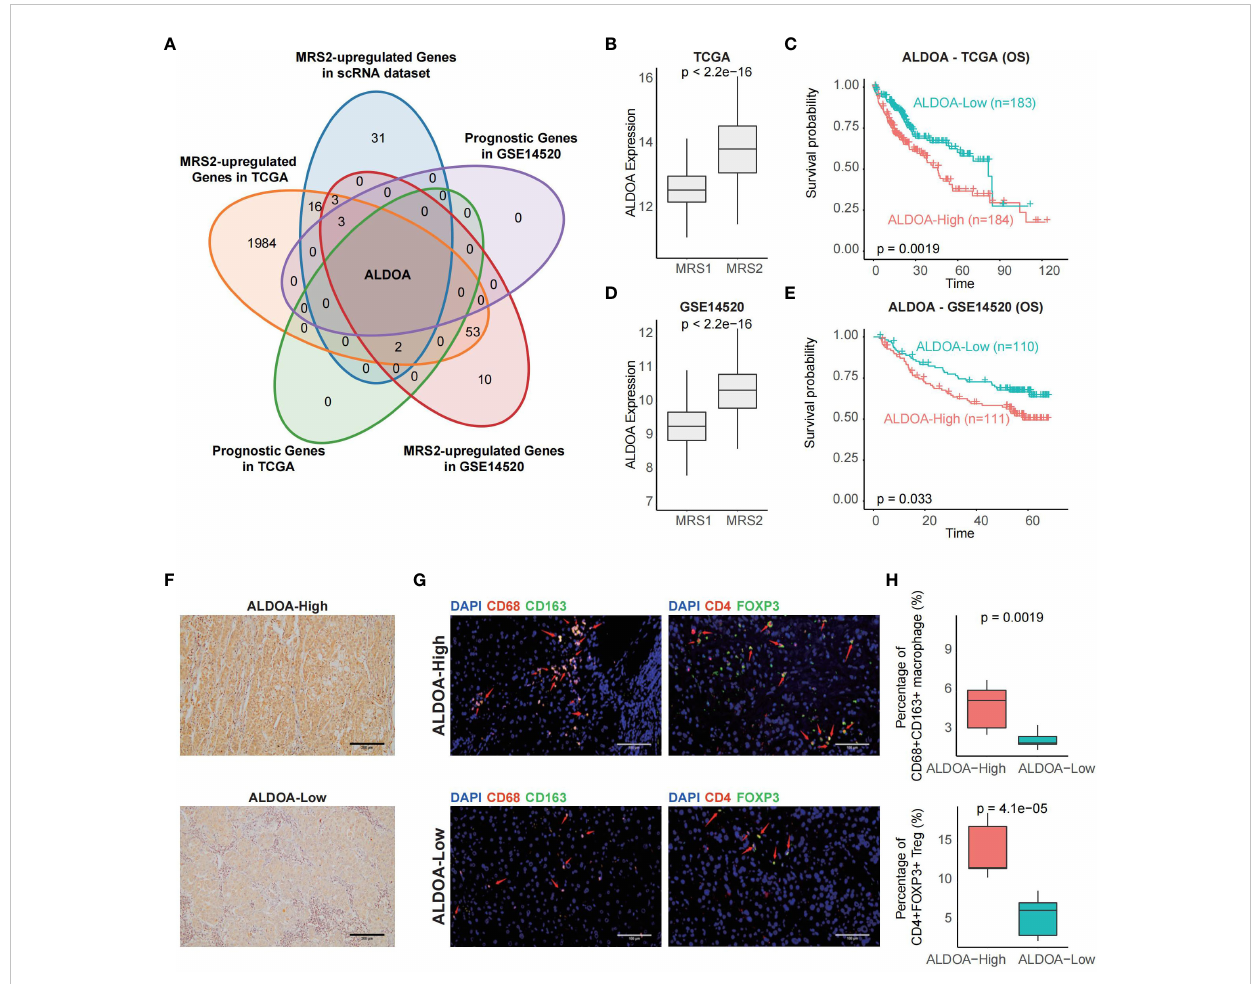
FIGURE 6 ALDOA overexpression is associated with an immunosuppressive TME (A) Venn plot showing the shared up-regulated genes with prognostic relevance in the MRS2-epithelial cells and patients with the MRS2 phenotype. (B) ALDOA expression in the MRS1 and MRS2 groups in the TCGA cohort. (C) OS of the ALDOA high and ALDOA low HCC patients in TCGA-LIHC cohort. The patients were strati fi ed based on the median expression. (D) ALDOA expression in MRS1 and MRS2 groups in the GSE14520 cohort. (E) OS of the ALDOAhigh and ALDOA1o HCC patients in GSE14520 cohort. (F) Representative images showing low immunostaining of ALDOA in the tumor tissues from ALDOAhigh and ALDOA' groups. (G) Left: Representative images of HCC tissues stained with anti-CD68 (red) and anti-CD163 (green) antibodies. Arrows depict the CD68+CD163+ macrophages. Scale bar, 100 m m. Right: Representative images of HCC tissues stained with anti-CD4 (red) and anti-FOXP3 (green) antibodies. Arrows depict the CD4+FOXP3+ Treg. Scale bar, 100 m m. DAPI (blue) was used to counterstain the nuclei. (H) Percentage of CD68+CD163+ macrophages (upper) and CD4+FOXP3+ Tregs (bottom) between ALDOAhigh and ALDOA low groups. Wilcoxon rank-sum test was used to measure the differences between